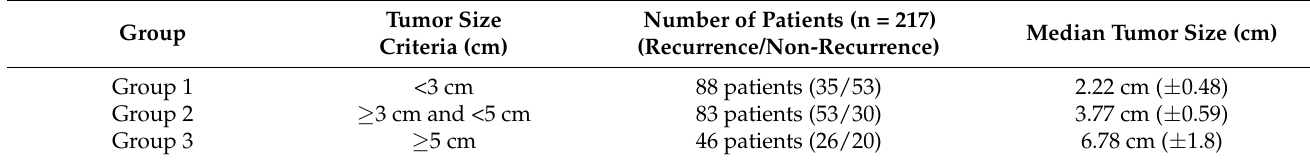
Table 4. Details of the patient groups according to the tumor size.